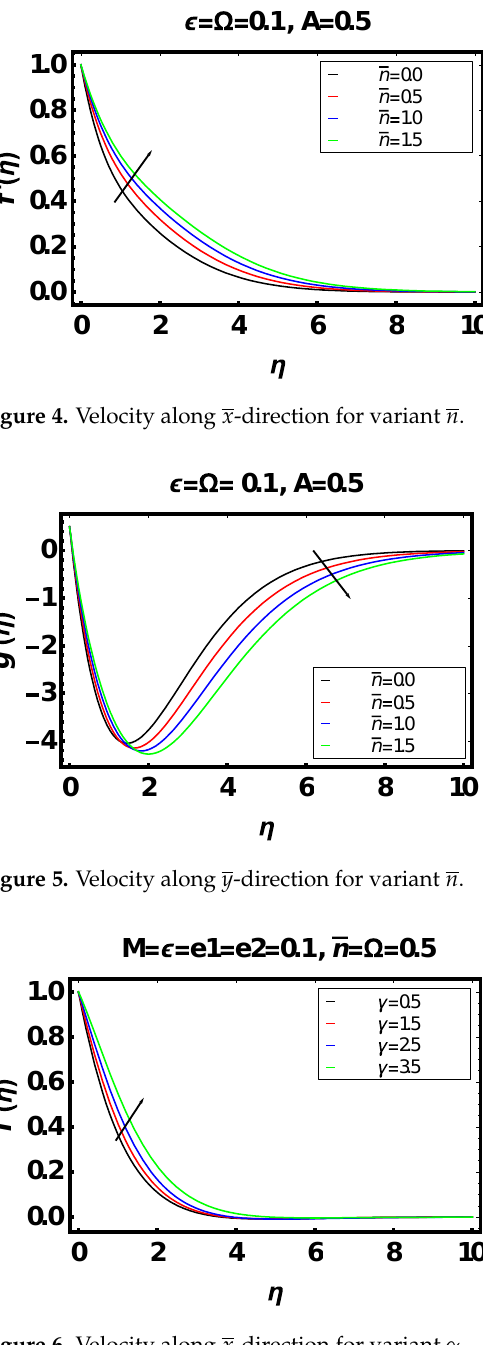
Figure 3. Velocity along 𝑥̅ -direction for variant Ω.